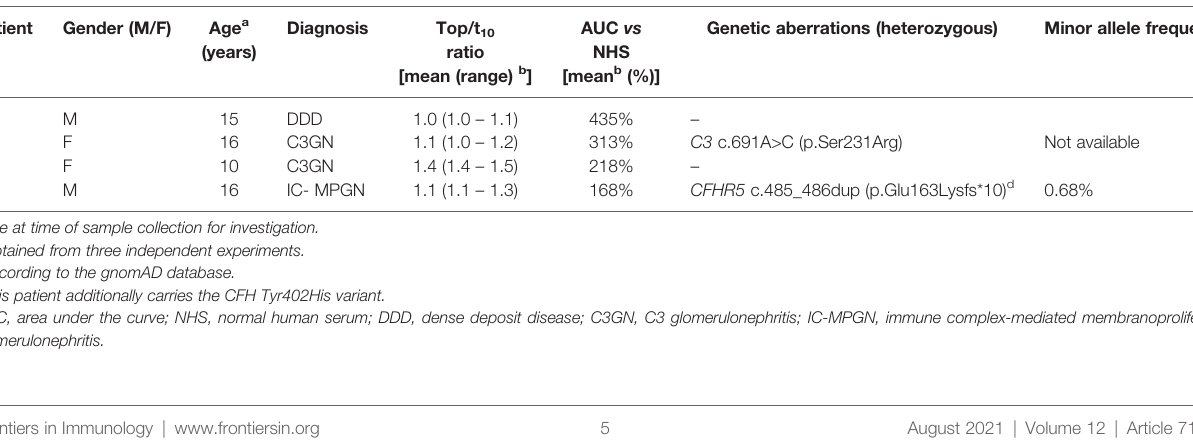
TABLE 1 | Details of the patients showing prolonged classical pathway convertase